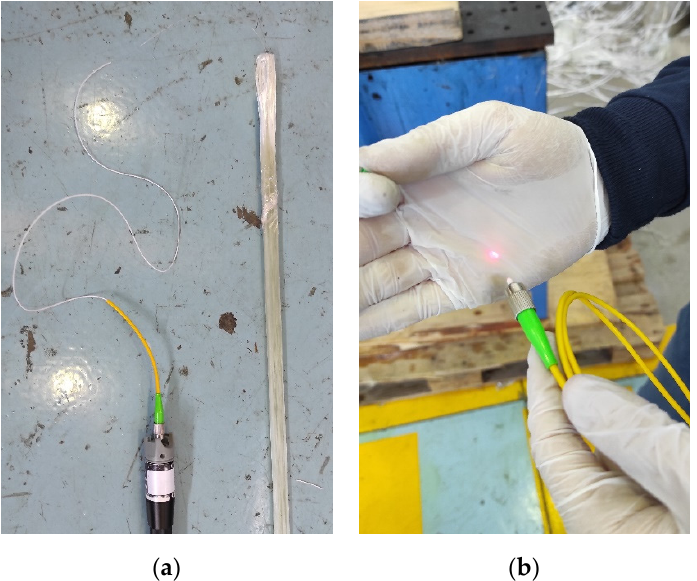
Figure 2. Single mode fibre embedded integration test: ( a ) fibre fault detector connexion on one embedded fibre end; ( b ) embedding survival test with light exiting the SMF on the other end of the embedded fibre.